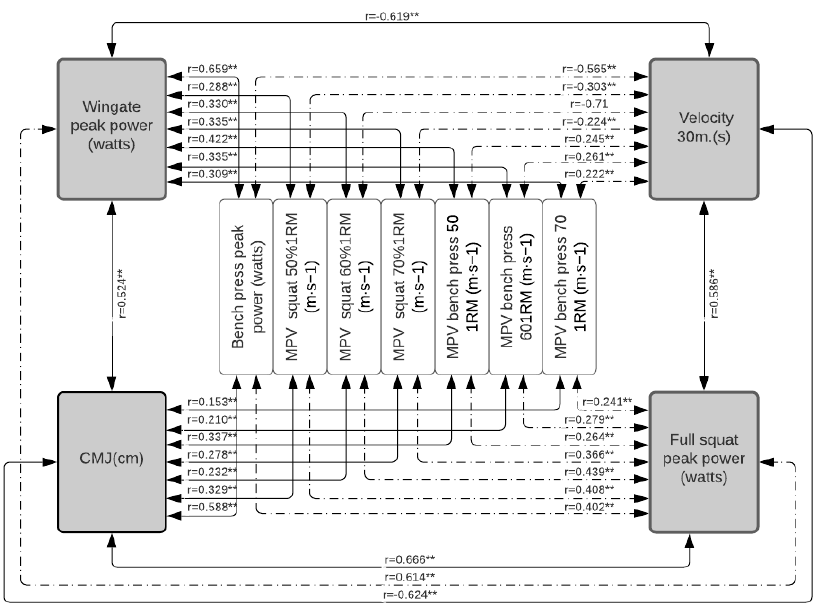
Figure 4. Correlation between power measurements in the total population. Significance: ** p <